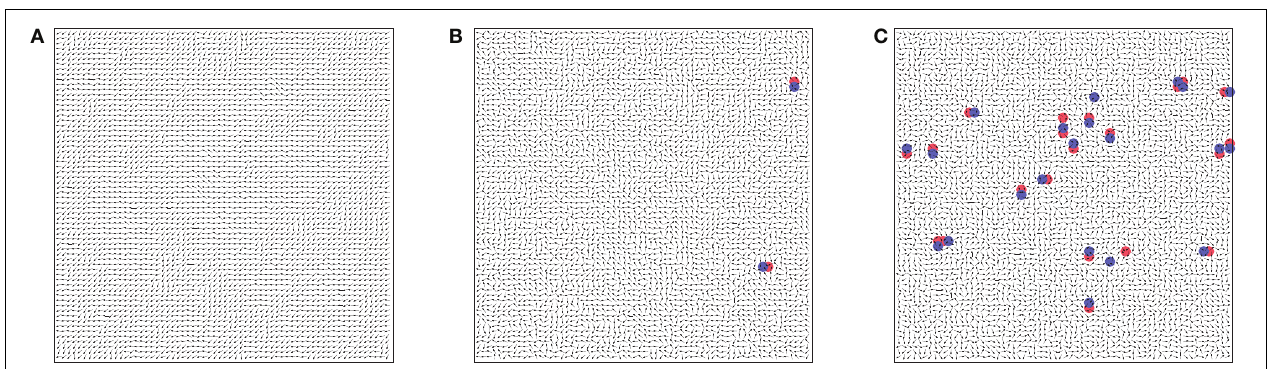
FIGURE 17 | The figure shows proliferation of vortices as noise is increased in a square lattice of length L = 64 with n = 4. (A) For η = 0 . 15 there are no vortices, (B) for η = 0 . 35 vortices begin to appear, there are only